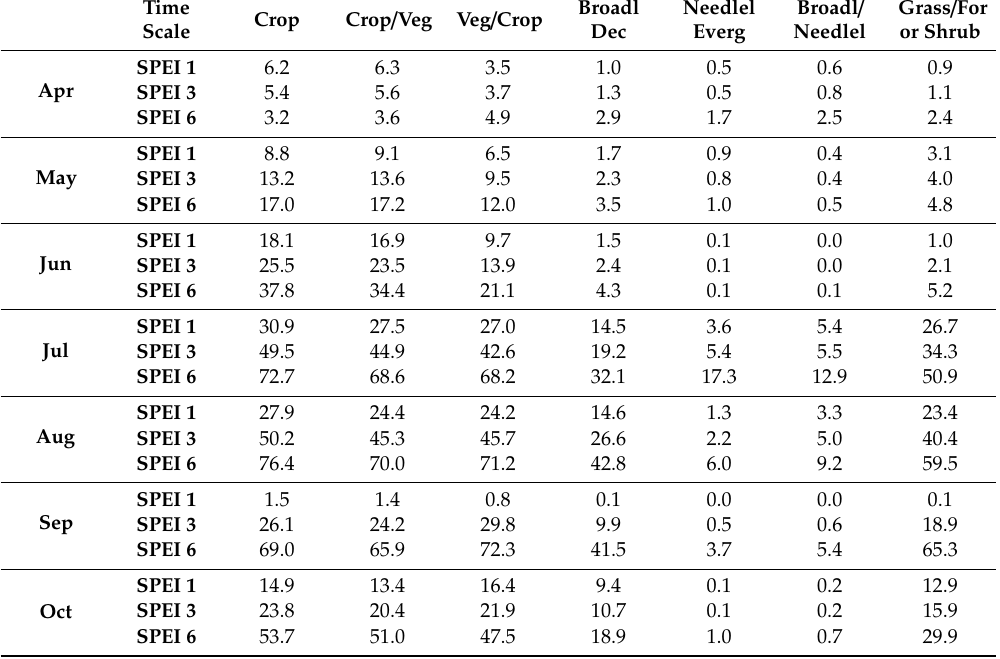
Table 4. Percentage area of each land cover class presenting significant positive correlations between NDVI and SPEI, for the months from April to October and time scales of 1, 3 and 6 months. Only land cover classes covering more than 1% of the area are